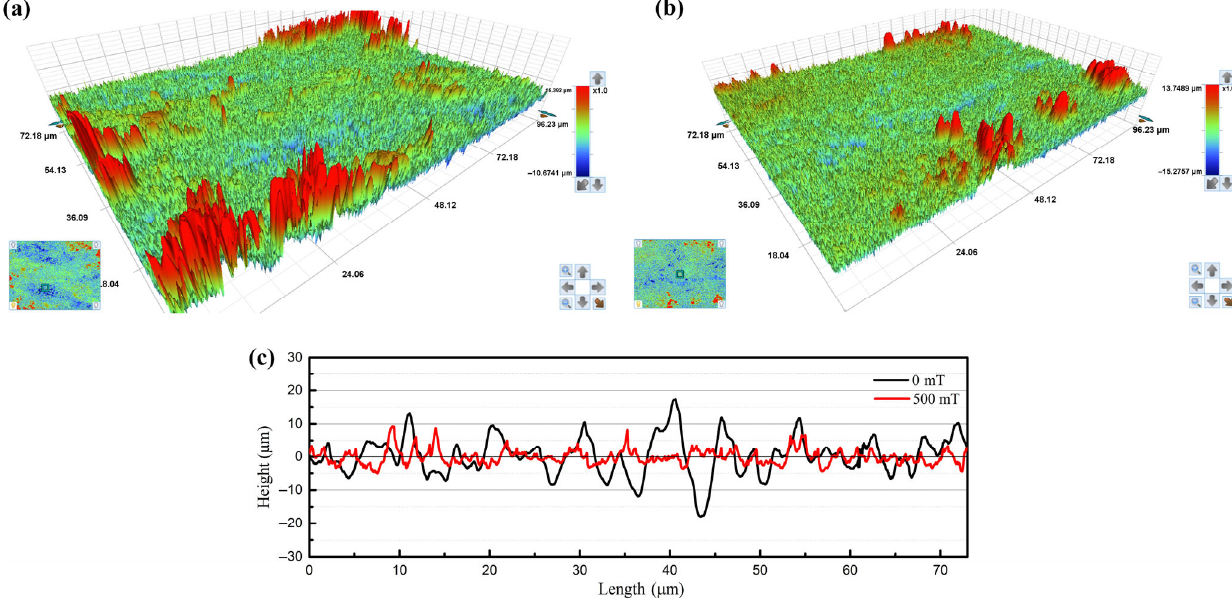
Fig. 12 White light interferometer test results of a typical MRE: (a) without magnetic field, (b) with magnetic field (500 mT), and (c) change of two-dimensional